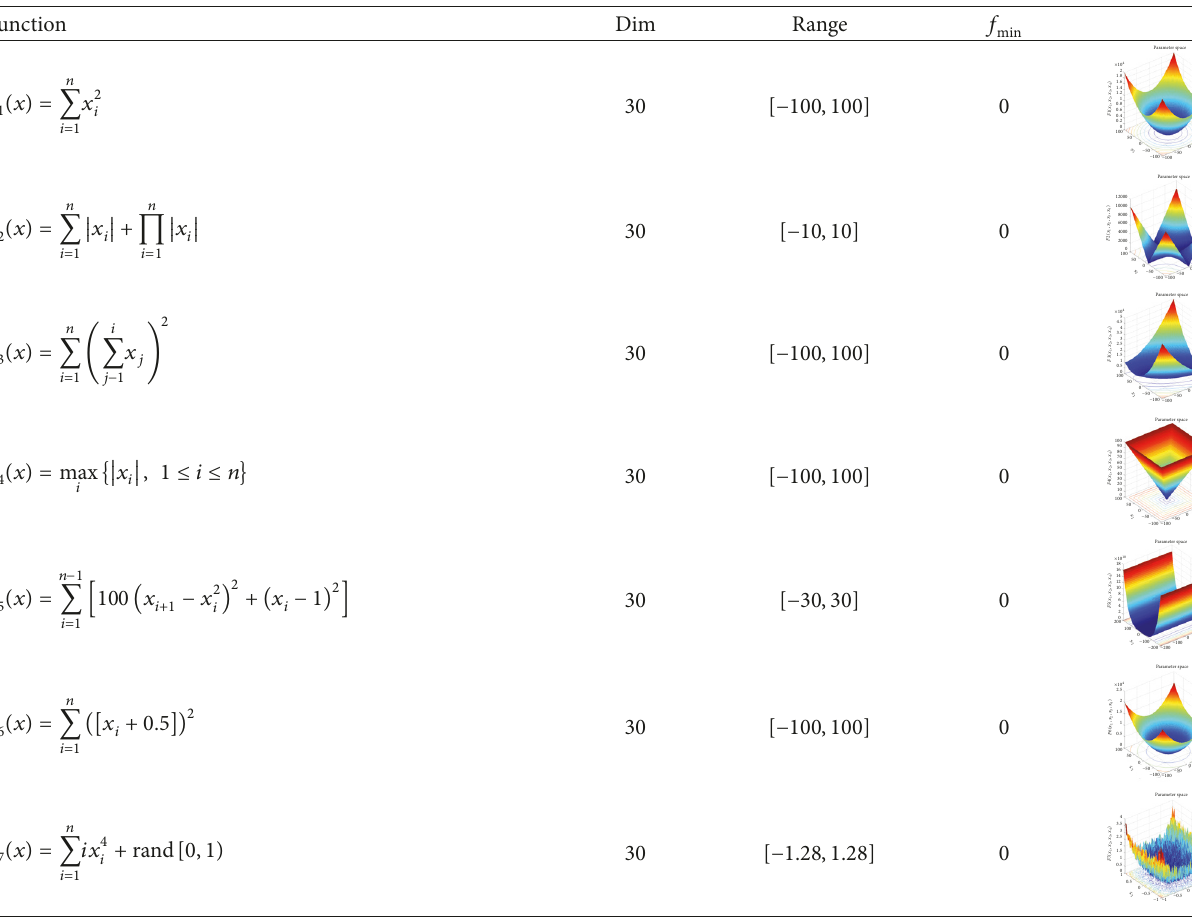
Table 1: Unimodal benchmark